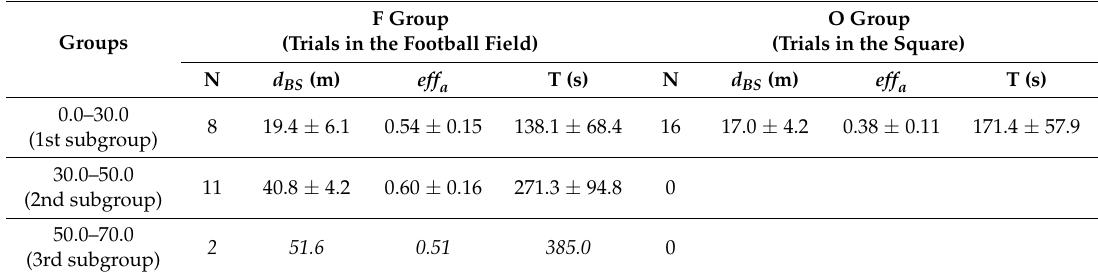
Table 2. Statistical results for the ERP method in outdoor environments.